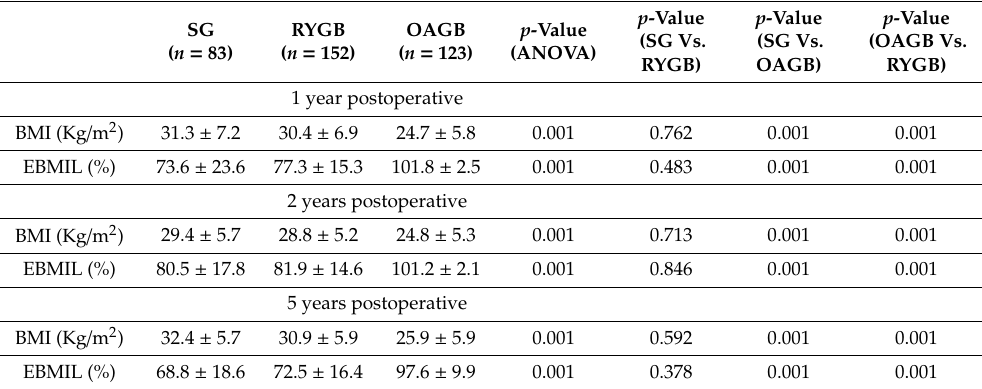
Table 2. Postoperative BMI and excess BMI loss (EBMIL) between groups.